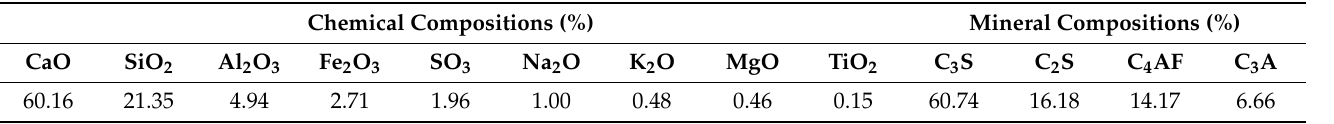
Table 1. The chemical compositions and the mineral compositions of OPC.